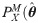
Synthetic inference based on some data Xobs and the SID likelihood PXM(θ^).The count data X1, … XM represents household level diarrhea cases among adults and juveniles under and contaminated (V = 1) and clean (V = 0) environments and is used to fit the generative model (observed likelihood) ℓM(η^) based on (1). The generated pseudo-data X1M,…XnM are then used to fit the SID model PXM(θ^) based on (2) and (3).